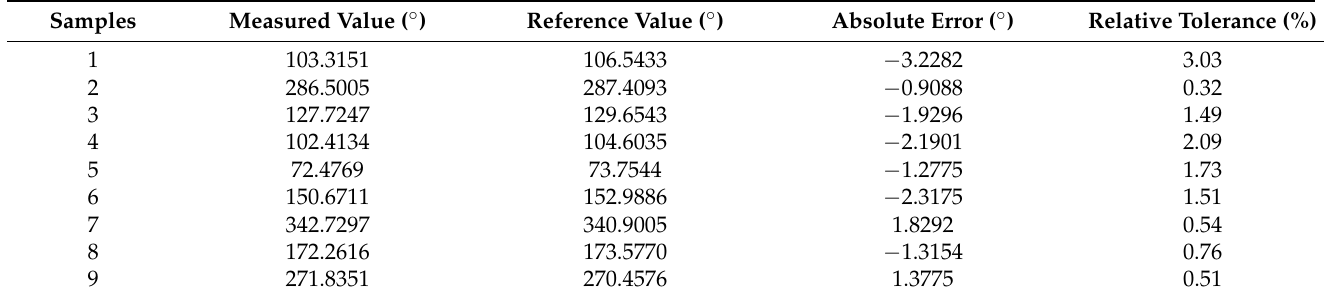
Table 3. Accuracy validation of study, the result from 3D scanner is used as truth data. The measured, reference value, the absolute and relative errors are shown for each sample.